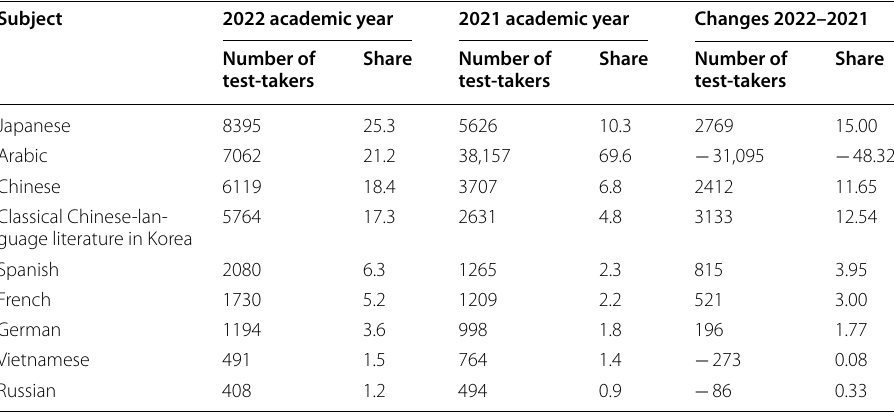
Table 1 Changes in the number of test-takers for second foreign language subjects in 2021 and 2022 (Korea Institute for Curriculum and Evaluation, 2020a, 2021c)